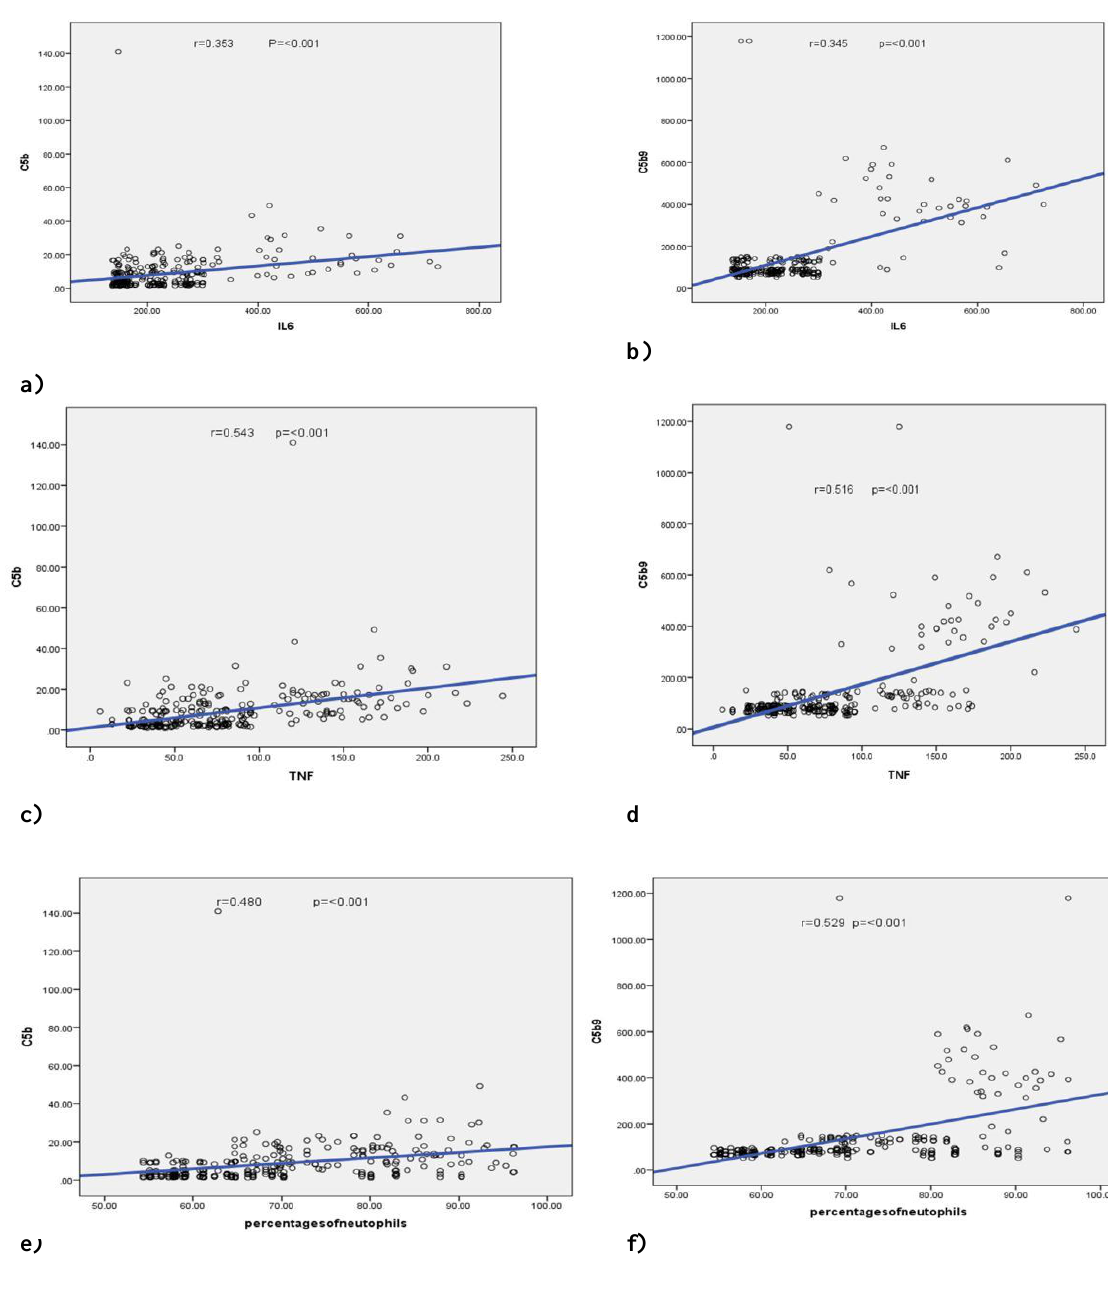
Figure 5. (a, b): Correlation of IL-6 with C5b and C5b-9 serum levels, (c, d): Correlation of TNF-α with C5b and C5b-9 serum levels, (e. f): Correction of neutrophil blood counts with C5b and C5b-9 serum levels in COVID- 19 patients with different